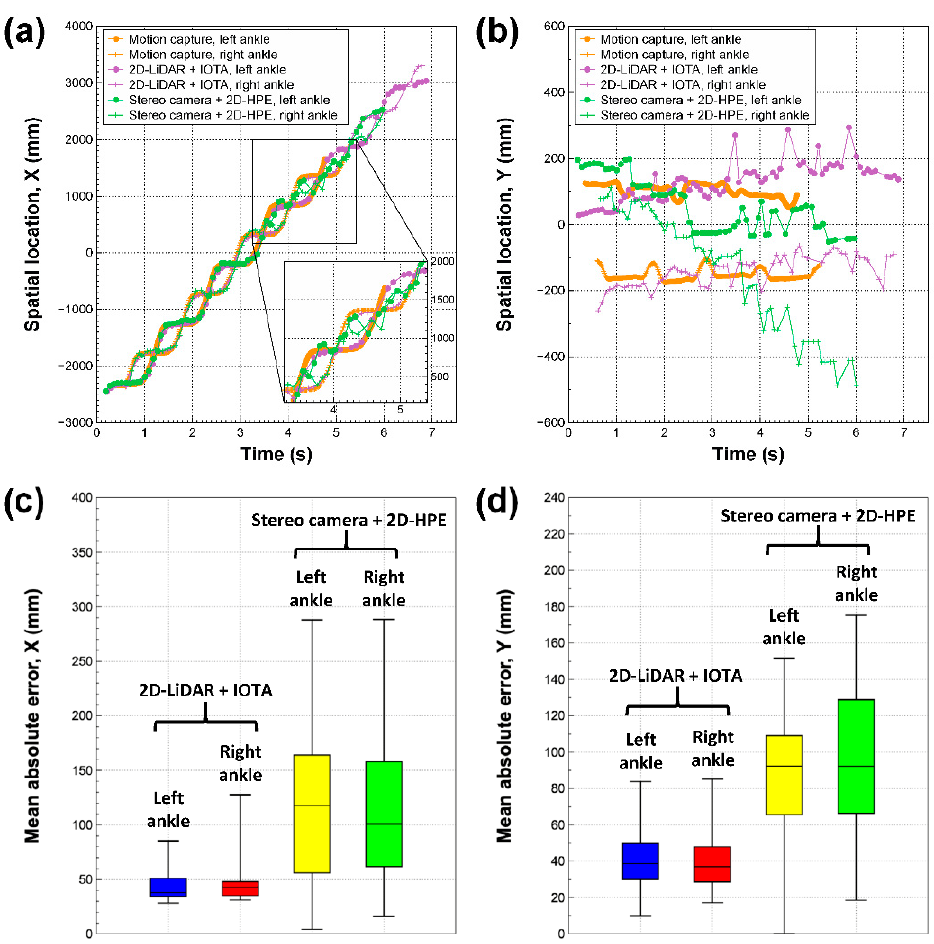
Figure 3. Ankle tracking results and accuracy via 2D-LiDAR with IOTA and stereo camera with 2D human pose estimation (2D-HPE). ( a , b ) Representative tracking results of spatiotemporal locations of ankles along the walking direction ( a ) and the lateral direction ( b ), gathered by motion capture system, 2D-LiDAR with IOTA, and stereo camera with 2D-HPE during the first trial of subject 4 (the entire tracking results are shown in Figures S5–S12). The sensor positions of 2D-LiDAR and stereo camera are at x = − 4000 mm. ( c , d ) Mean absolute errors of the spatial locations for 2D-LiDAR with IOTA and stereo camera with 2D-HPE along the walking direction ( c ) and along the lateral direction ( d ), respectively.